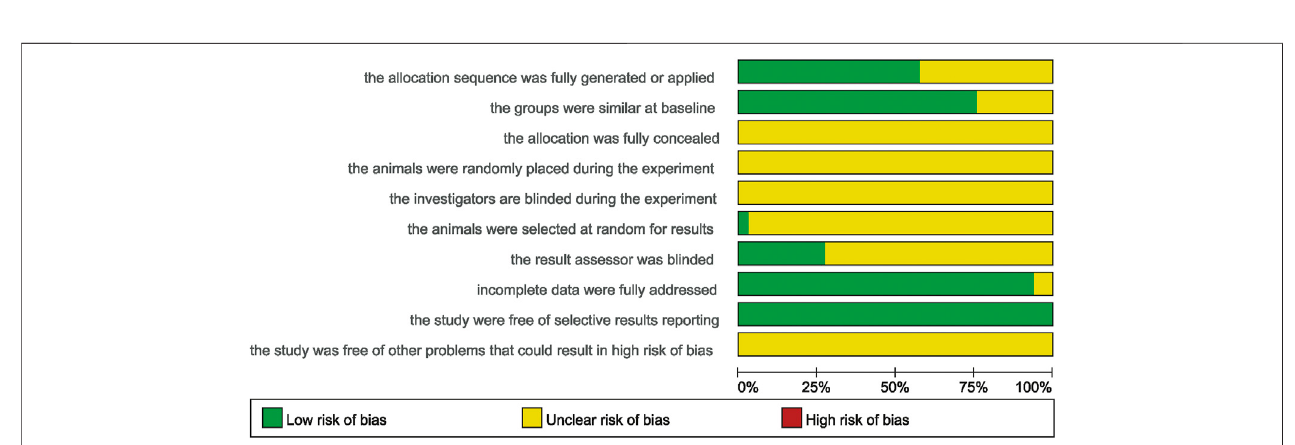
FIGURE 3 | The risk of bias graph of included